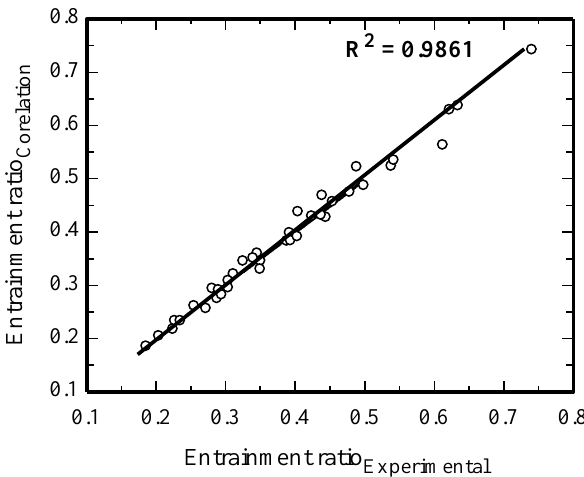
Figure 12. Validation of empirical correlation.